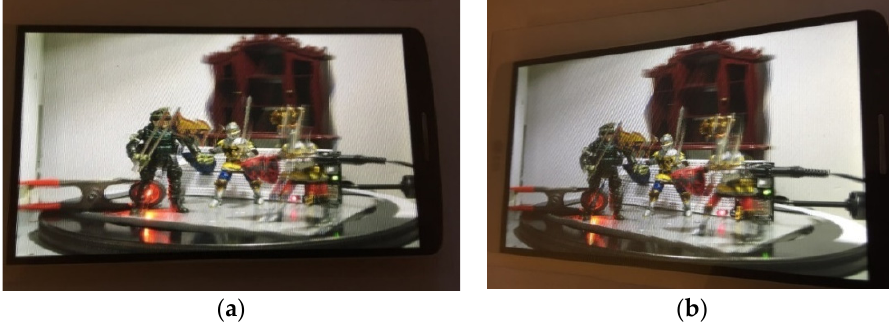
Figure 13. Images on the mobile phone screen from different viewing angles. ( a ) view from the center; ( b ) view from the right.